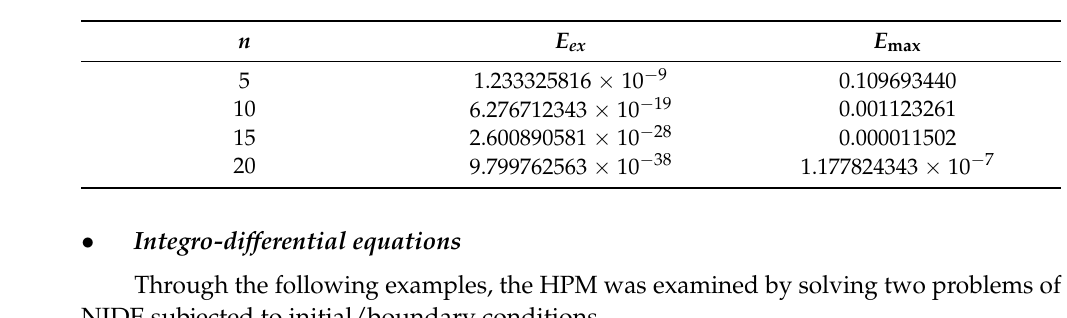
Table 1. A comparison between the exact and maximum absolute truncation errors for different values of n